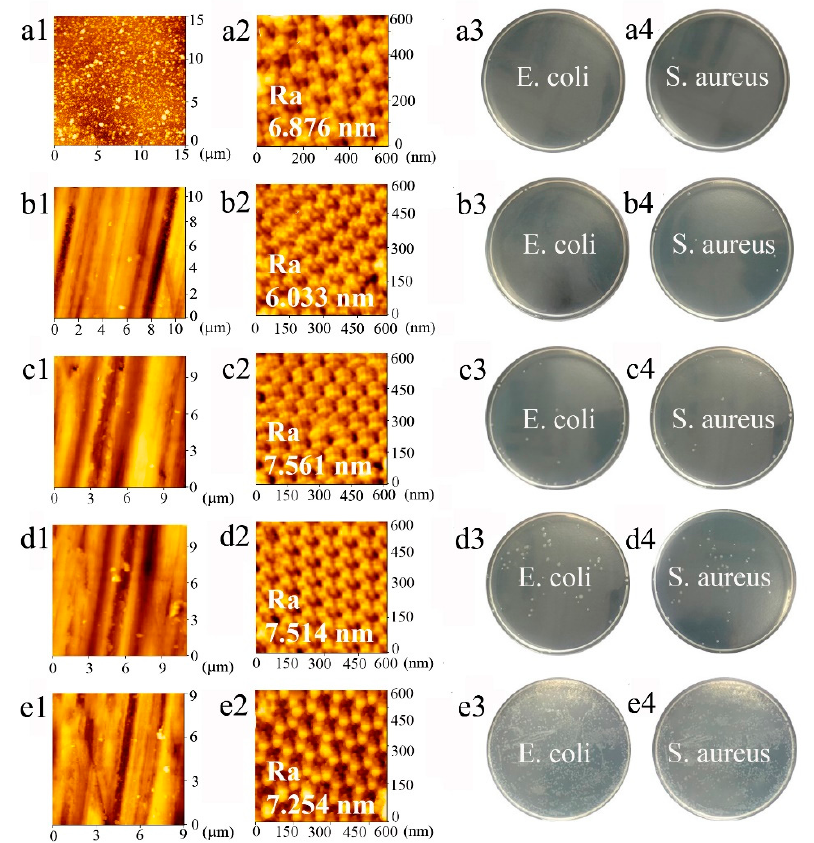
Figure 10. AFM images of the coatings after abrasion and the corresponding anti-adhesion performance at the thickness loss of ( a1 – a4 ) 0 μ m, ( b1 – b4 ) 5 μ m, ( c1 – c4 ) 10 μ m, ( d1 – d4 ) 15 μ m, ( e1 – e4 ) 20 μ m.